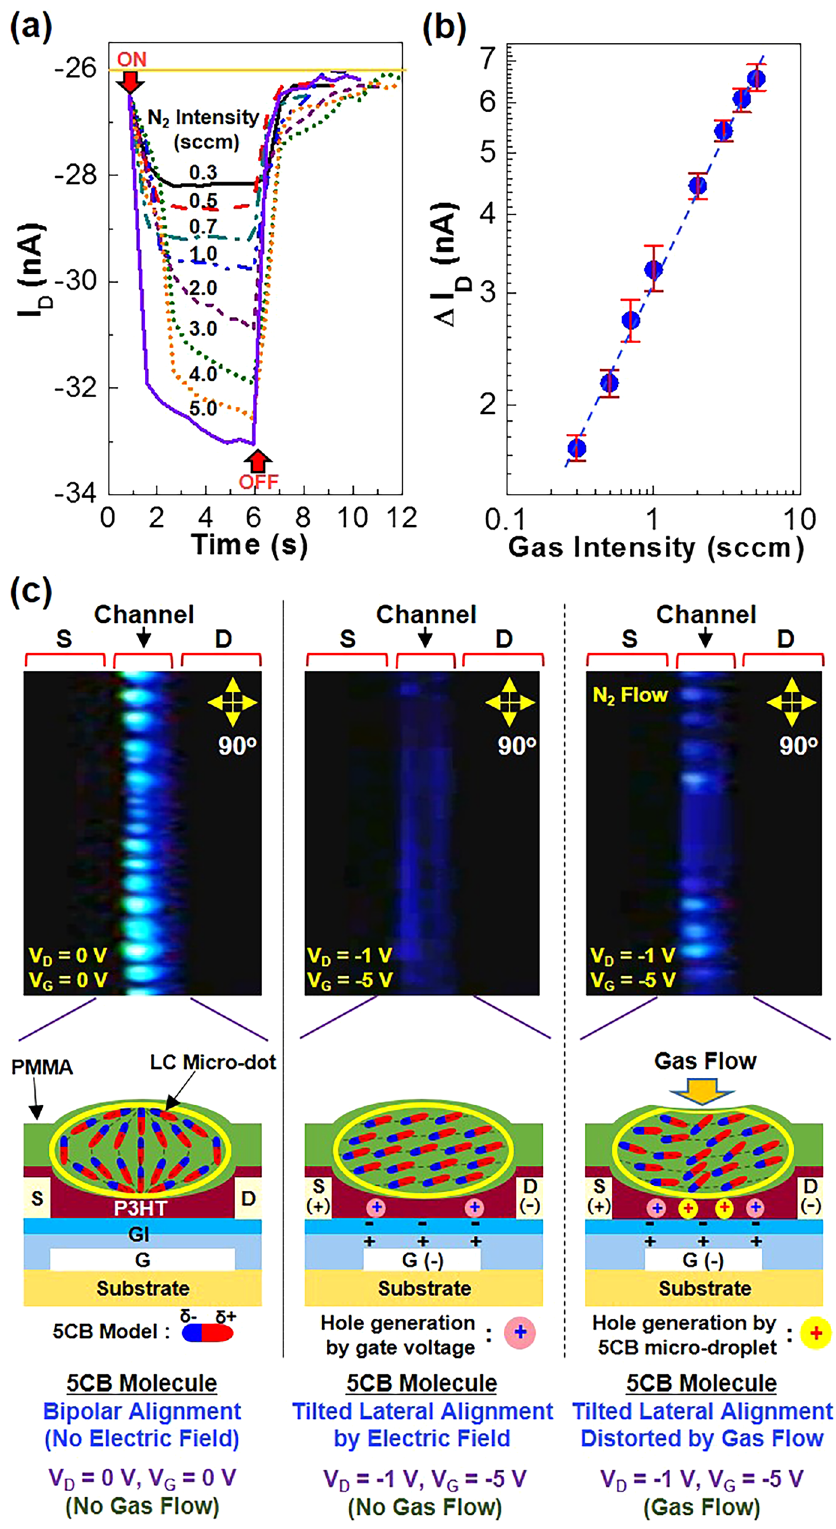
Figure 2. Sensing performances by weak gas flow stimulations and mechanism. ( a ) Drain current (I D ) as a function of time under stimulation with nitrogen gas flows (gas intensity = 0.3~5.0 sccm for 5 s) for the flexible PDLC-i-OFET devices. ( b ) Drain current change ( Δ I D ) before and after nitrogen gas stimulations as a function of gas intensity (note that more than sixteen devices were measured). ( c ) Change of 5CB alignment in the channel region of PDLC-i-OFET devices according to applied voltages and nitrogen gas stimulations: (top) Polarized optical microscope images, (bottom) illustrations for possible orientation of 5CB molecules in the LC micro-dots in the channel